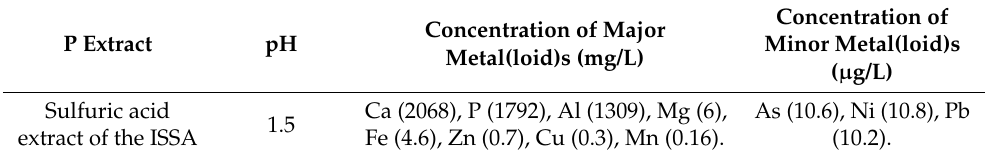
Table 1. Physical and chemical characteristics and heavy metal content in the P extract of the ISSA.